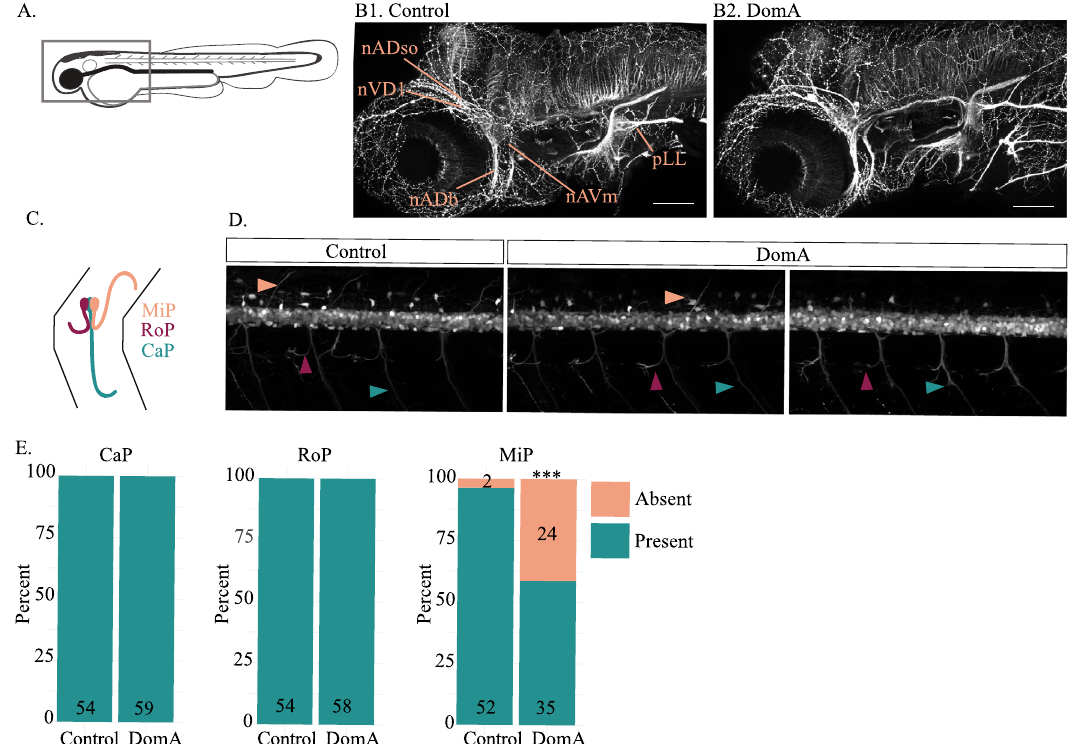
Figure 5. Exposure to DomA at 2 dpf does not grossly alter selected sensory neuron structures or the main axons of two of the three primary motor neurons. ( A ) Diagram of 2.5 dpf embryos laterally mounted and immunostained with anti-acetylated tubulin. The rectangle delineates the approximate area that was imaged. ( B ) Representative images of control (n = 35) and DomA-exposed larvae (n = 29) immunostained with anti-acetylated tubulin. Labels point to both the sensory ganglia that comprise the anterior lateral line (nADso, nVDI, nADb, nAVm) and to the peripheral lateral line (pLL). ( C ) Diagram of the axonal trajectories in the three types of primary motor neurons assessed in Tg(olig2:EGFP) fish. ( D ) Representative images of Tg(olig2:EGFP) × Tg(sox10:mRFP) fish exposed to vehicle or to DomA at 2 dpf then imaged at 2.5 dpf. Peach arrows point to the MiP main axons, magenta arrows point to the RoP main axons, and teal arrows point to the CaP main axons. Scale bar = 50 μm. These fish were the same fish used in Fig. 1, with only the EGFP shown. ( E ) Presence or absence of intact main axons of the three types of primary motor neurons in control and DomA- exposed fish. *** p < 0.001. Abbreviations: nADso superior opthalmic ramus of the anterodorsal lateral line nerve, nVDI dorsolateral nerve of the trigeminal ganglion, nADb buccal ramus of the anterodorsal lateral line nerve or nAVm the mandibular ramus of the anterior lateral line nerve. MiP Middle primary motor neuron, RoP rostral primary motor neuron, CaP Caudal primary motor